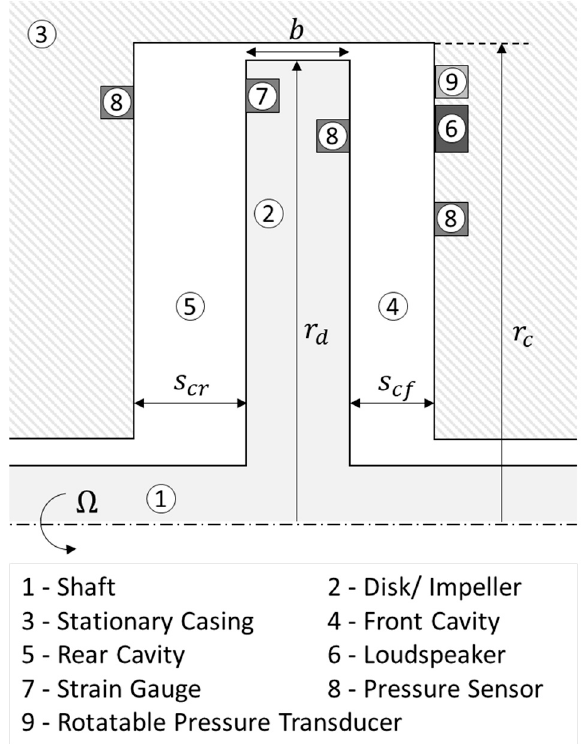
Figure 4. Test rig setup and measurement equipment.